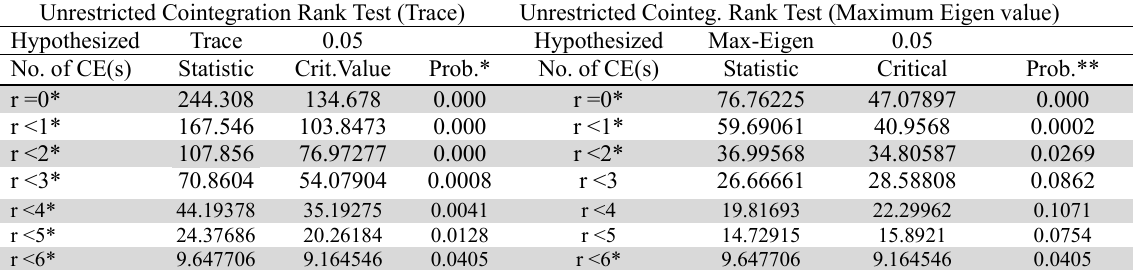
Johansen cointegration test results for China Unrestricted Cointegration Rank Test (Trace) Unrestricted Cointeg. Rank Test (Maximum Eigen value)